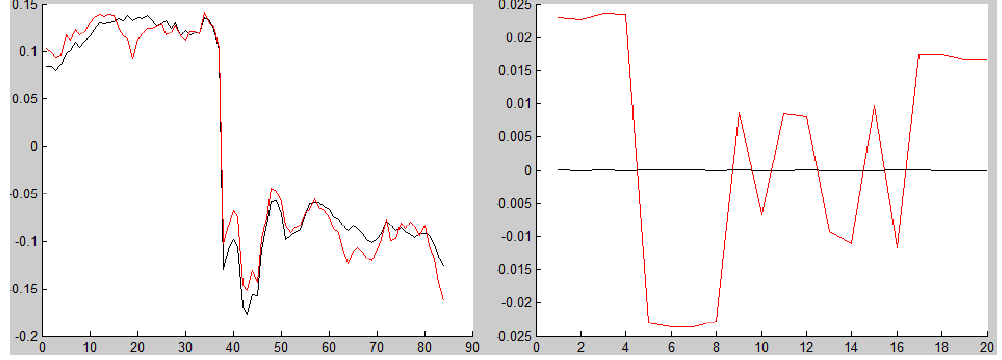
Figure 20. Left: The red line is the target’s spectrum and the black line measures the background (it was taken from the scene in Figure 4). Right: The same two vectors after the projection of the separating mapping. The x-axis represents the wavelengths and the y-axis represents the wavelengths amplitude before (left) and after (right) the application of the projection.